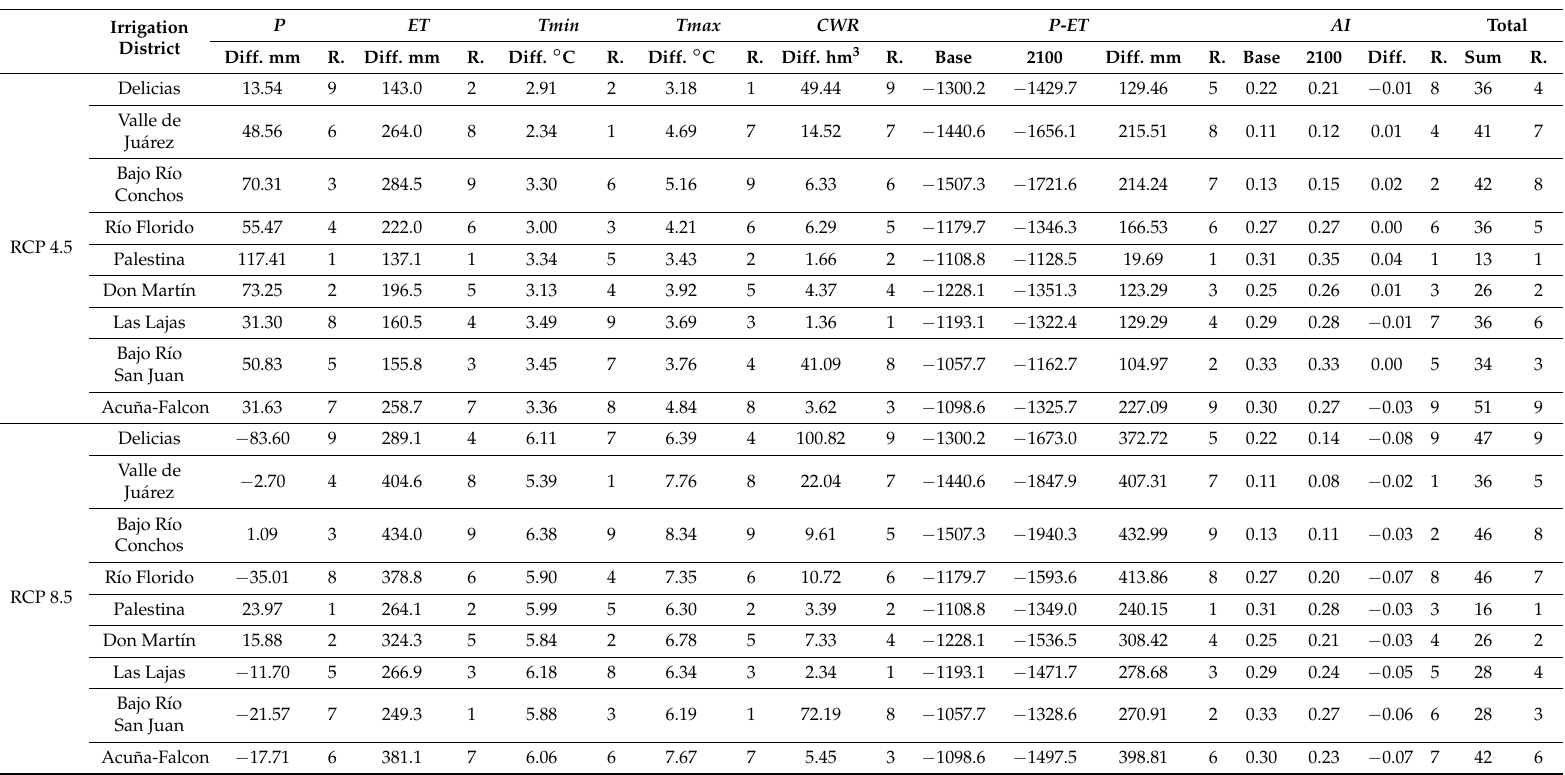
Table 1. Extent of climate change effects on the IDs between the 1980–2009 base period and the 2075–2099 period projected according to the RCP 4.5 and RCP8.5 climate change